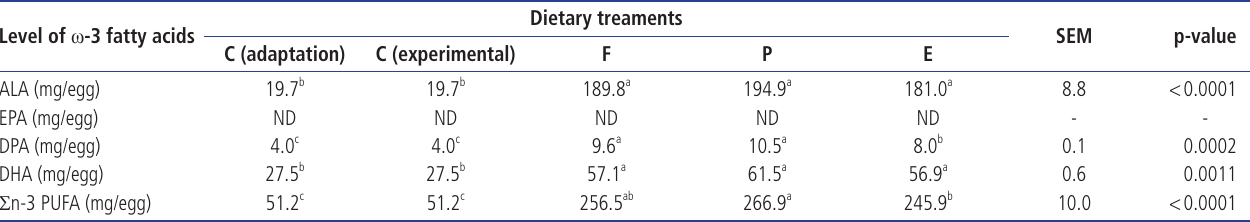
Table 4. Effect of supplementation with ALA resources on egg n-3 fatty acids at week 3 Level of ω -3 fatty